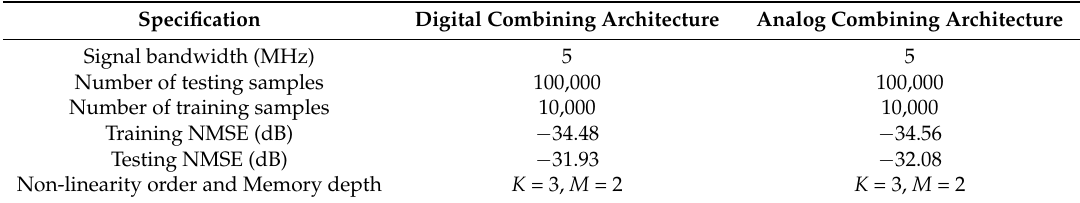
Table 7. Summary of performance evaluation of different architectures for LTE signals with a 5 MHz